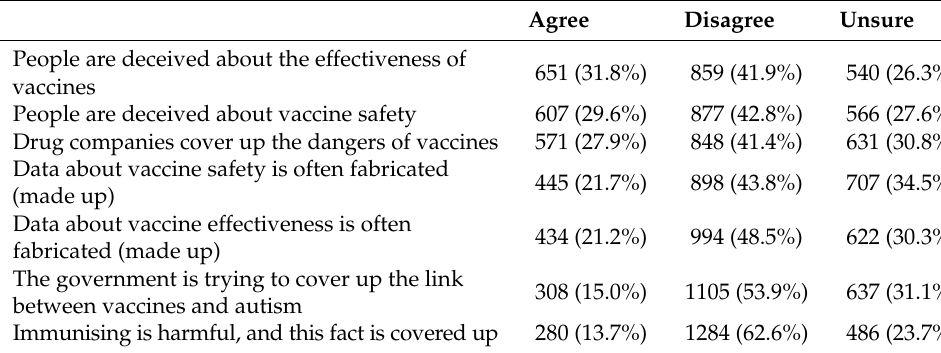
Table 6. Vaccine-related conspiracy